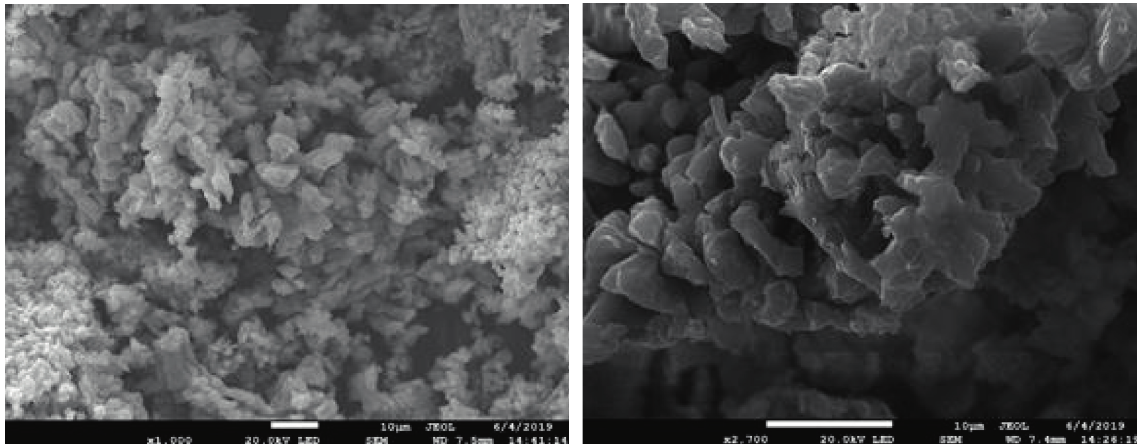
Figure 7: SEM images of chicken eggshell ash-derived CaO which were calcined at 800 ° C.